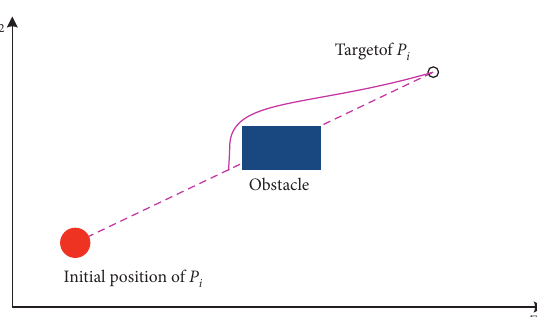
Figure 2: 2D schematic representation of P − Z in Z plane. 1 2